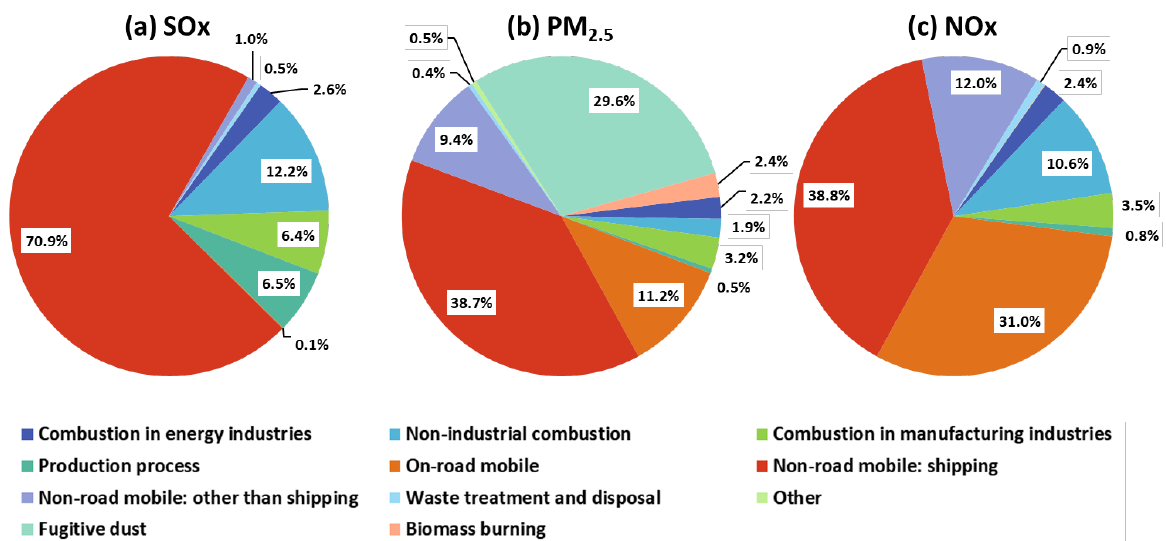
Figure 5. CAPSS2016 ratios by emission sources for ( a ) SOx, ( b ) PM 2.5, and ( c ) NOx in Table 3. Annual contribution rates (%) of SO 2 , PM 2.5 , and NO 2 for each local region from ship emis- sions from Busan.